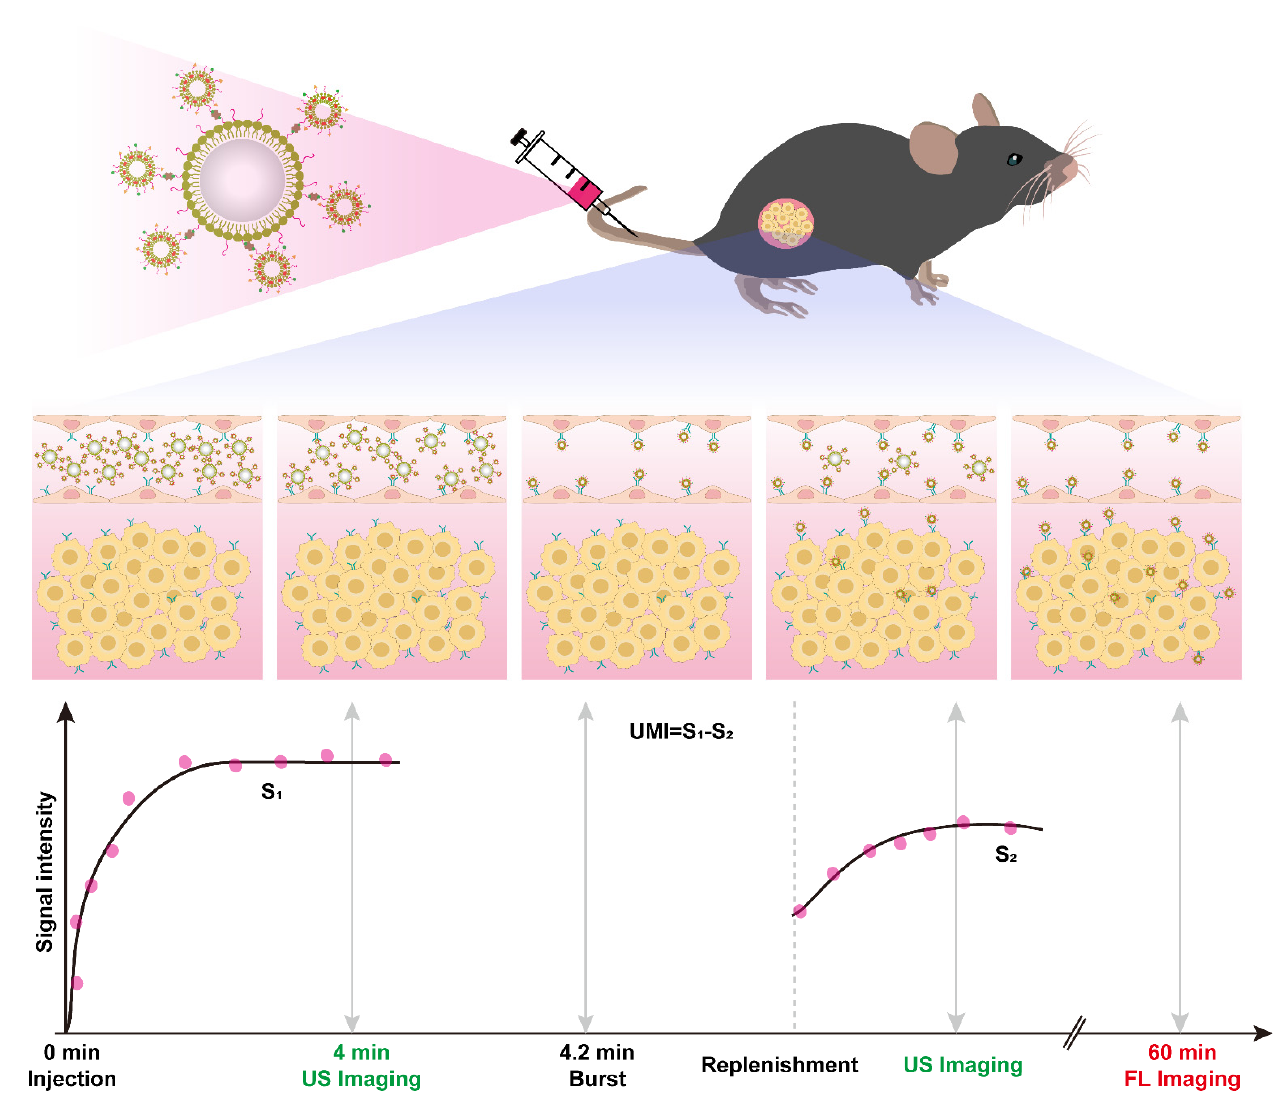
Figure 1. Schematic diagram of dual-modality imaging of tumor via quantum-dots-liposome– microbubble complexes (iRGD-QDLM). The α v β 3-targeting iRGD-QDLM was injected via the tail vein of mice. After allowing 4 min for these targeting MBs to bind with their receptors, a high intensity acoustic burst was used to collapse the iRGD-QDLM. The contrast signals of the binding iRGD-QDLM, which represents the molecular imaging signals for α v β 3 receptors, can be calculated by subtracting the post-burst contrast/replenishment signals (S2) from the 1st pre-burst contrast signals (S1). iRGD-QDL attached to α v β 3 integrin in endothelial cells can be detected by fluores- cent imaging. Moreover, they can be delivered into tumor by ultrasound-mediated microbubble destruction and adhered to α v β 3 integrin in breast cancer cells, achieving transvascular fluorescent